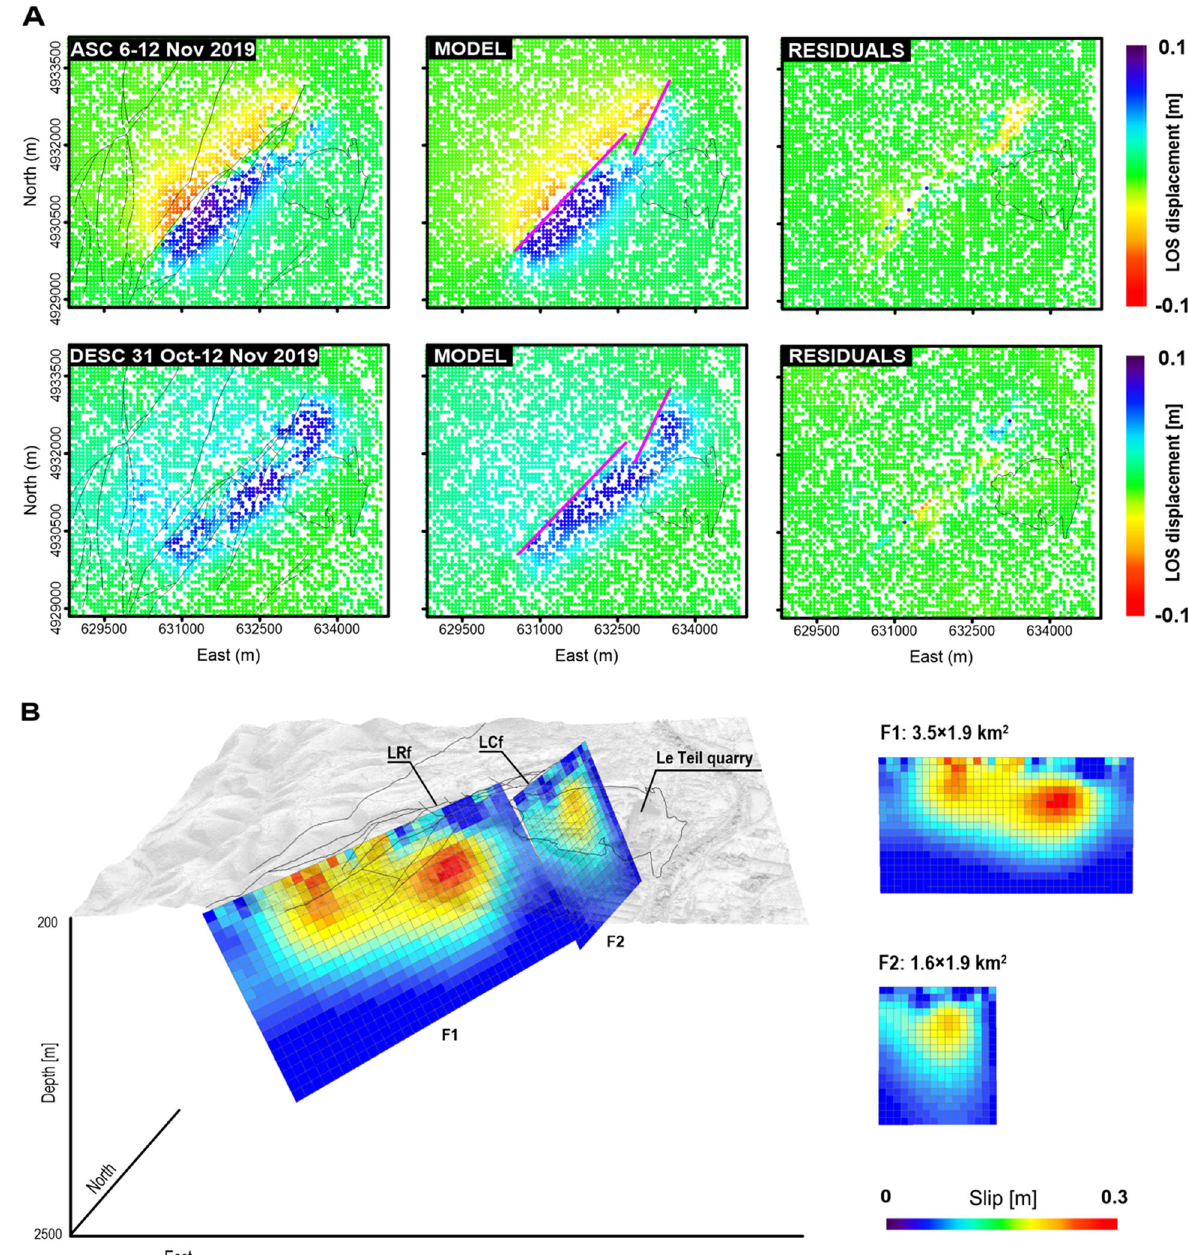
Fig. 2 Modeling of the DInSAR data. a Data, modeling results, and residuals for line-of-sight surface displacement for ascending (ASC) and descending (DESC) orbits DinSAR interferograms. The fault trace of the two retrieved rupture planes is indicated by magenta lines, while the black contour depicts the Le Teil quarry. b The dislocation resulting from the inversion of the ground deformation data is displayed in both perspective and plane view. Each pixel is 100 × 100 m 2 both interferograms, several fringes located near the epicentral area are clearly Aperture Radar (SAR) Interferometry (DInSAR) technique, which allows the visible; note that each fringe corresponds to a LOS displacement of about 2.8cm analysis of surface displacements along the radar line-of-sight (LOS). The SAR data (i.e., half of the employed S1 C-band wavelength λ = 5.546 cm). Subsequently, considered were acquired by the Sentinel-1 (S1) constellation of the Copernicus starting from the selected interferograms, we generated their corresponding LOS European Program. Bene fi ting from the short revisit time and the small spatial baseline separation of the S1 constellation, we generated several coseismic differ- ential interferograms (Supplementary Table 2) with a spatial sampling of about 15m following an averaging operation (multilook) in the azimuth direction to reduce the speckle noise. Among the generated interferograms we selected those less affected by undesired phase artifacts (atmospheric phase delays, decorrelation the orientation of the LRf. Moreover, a clear asymmetry is clearly visible in the noise, etc.) for the seismic source modeling discussed in the following section, thus northern sector of the deformed zone, in correspondence of a minor fault located at preserving good spatial coverage and interferometric coherence. In particular, the the base of La Chade Hill ’ s NW fl ank (Supplementary Fig. 2E, F), suggesting a employed S1 data pairs were acquired on November 6 – 12, 2019 (Supplementary complex geometry of the ruptured area. This is also evident in the map of the Fig. 2A), and on October 31 and November 12, 2019 (Supplementary Fig. 2B) vertical component of the retrieved deformation pattern (Supplementary Fig. 3A) along the ascending (ASC) and the descending (DESC) orbits, respectively. On that we computed from the unwrapped interferograms, together with the East-